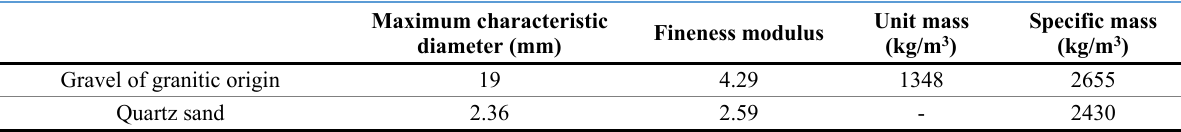
Table 2. Material